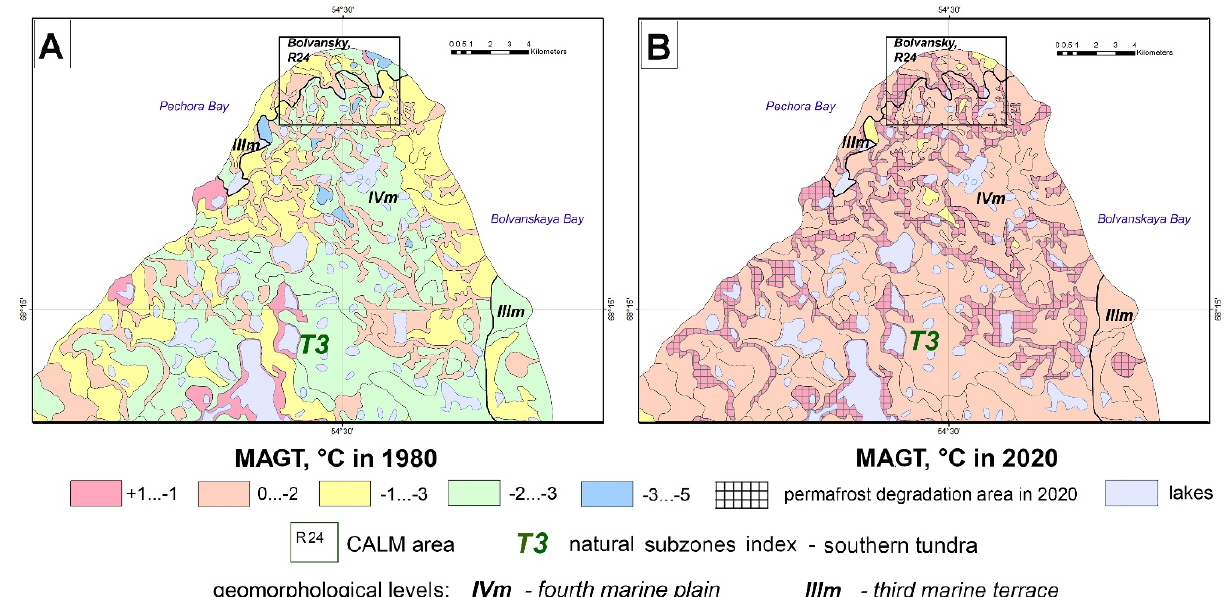
Figure 8. Changes in the mean annual ground temperature in southern tundra of the Russian European North for two time intervals: ( A ) in the 1980s and ( B ) the modern period, 2020.